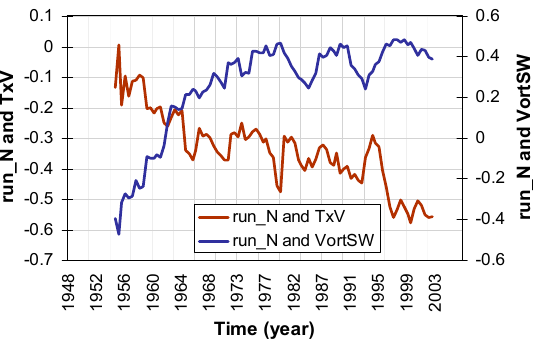
Figure 10. Correlation between run_N and TxValencia and VortSW (28-month window).